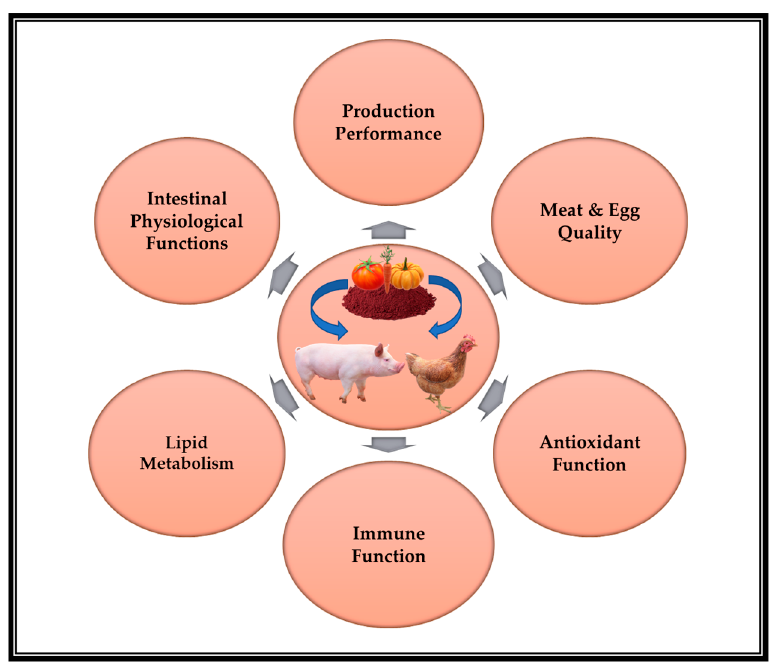
Figure 2. The overview diagram of the beneficial effects of lycopene on swine and poultry.